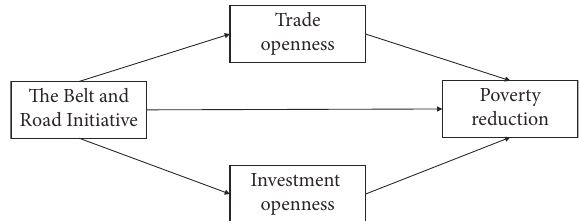
Figure 1: Mechanism of the BRI on poverty reduction in countries along the